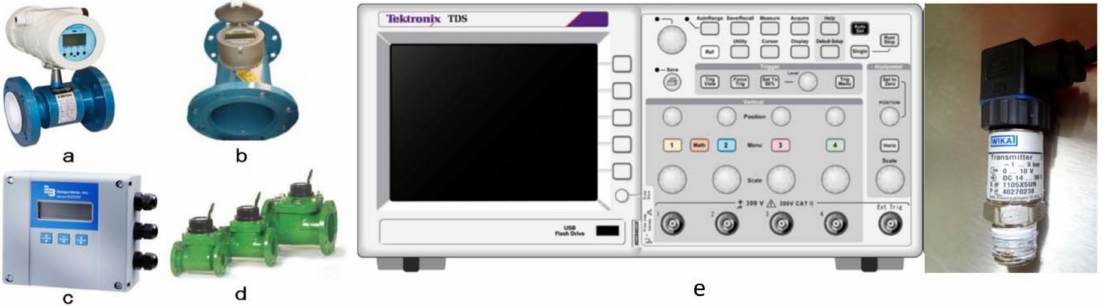
Figure 2. Equipment to measure flow (electromagnetic: ( a , c ), propeller volumetric: ( b , d )) and pressure around the cross-junction (oscilloscope and pressure transducer: ( e